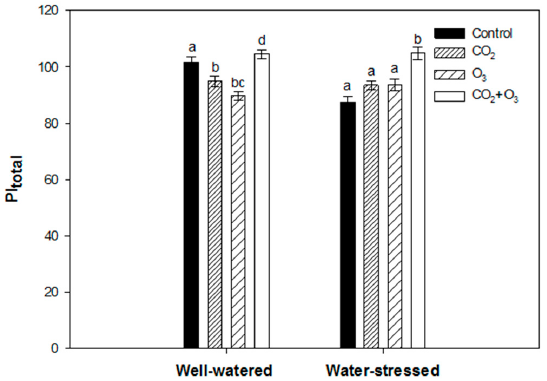
Figure 3. Average (of all weeks) PI total of canola plants exposed to CO 2 , O 3 and CO 2 + O 3 under well-watered and water-stressed conditions for four weeks. For the same water treatment, different letters show statistically significant differences ( p < 0.05).